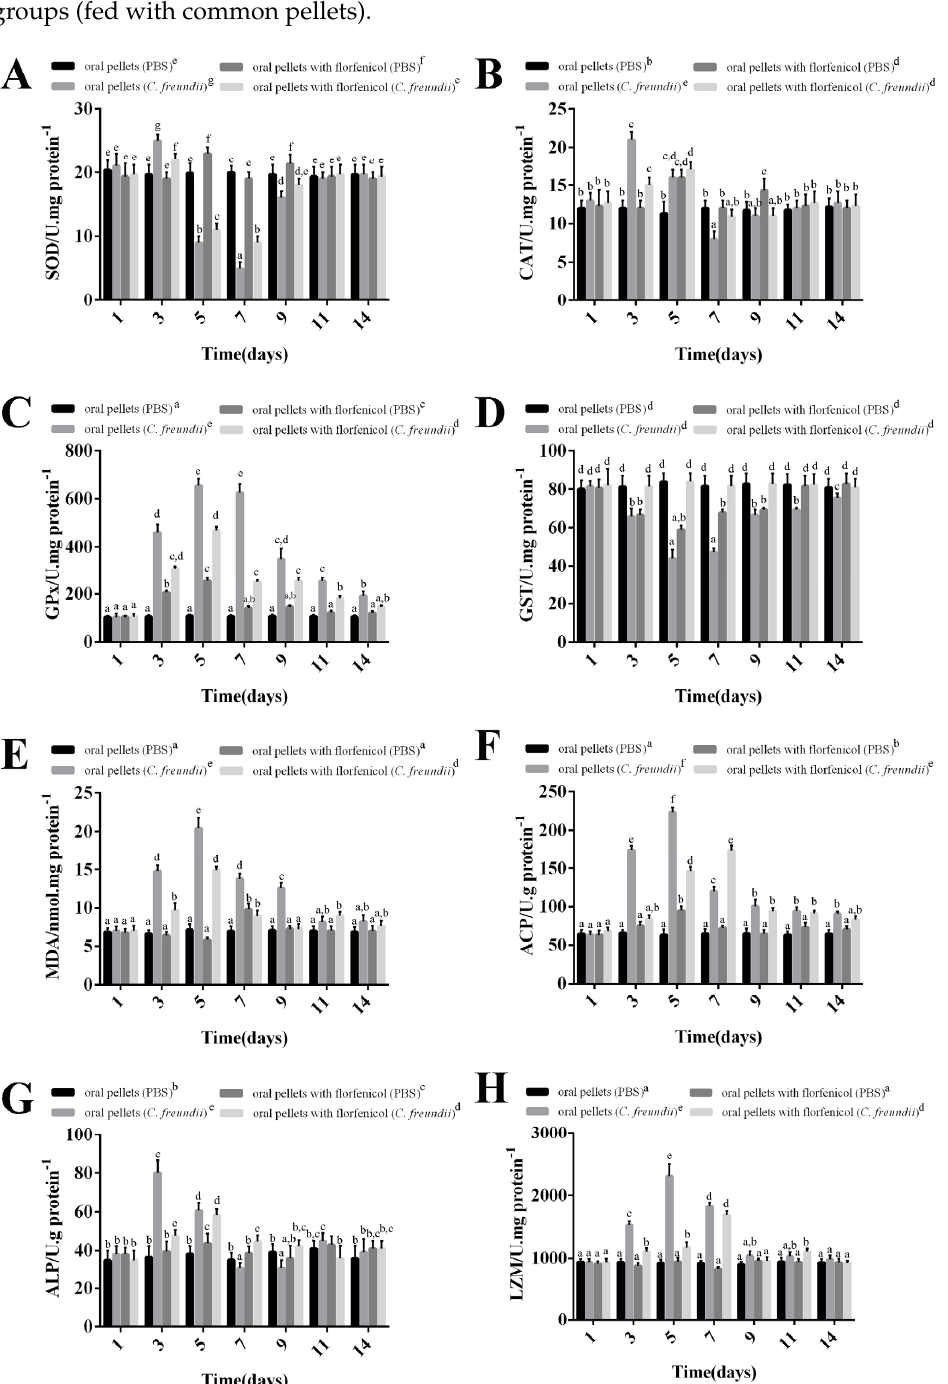
Figure 9. Changes in non-specific immune parameters of M. rosenbergii hepatopancreas at 1-, 3-, 5-, 7-, 9-, 11-, and 14 - days after C. freundii infection. ( A ) SOD, ( B ) CAT, ( C ) GPx, ( D ) GST, ( E ) MDA, ( F ) ACP, ( G ) ALP, and ( H ) LZM activities. Data are presented as mean ± SEM ( n = 3); different graphemes (a–g) indicate significant difference values of non-specific immune parameters at p < 0.05.